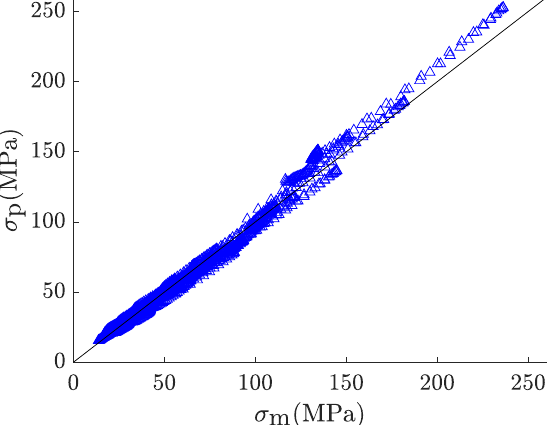
Figure A2. The correlation between σ m and σ p using the power law model.